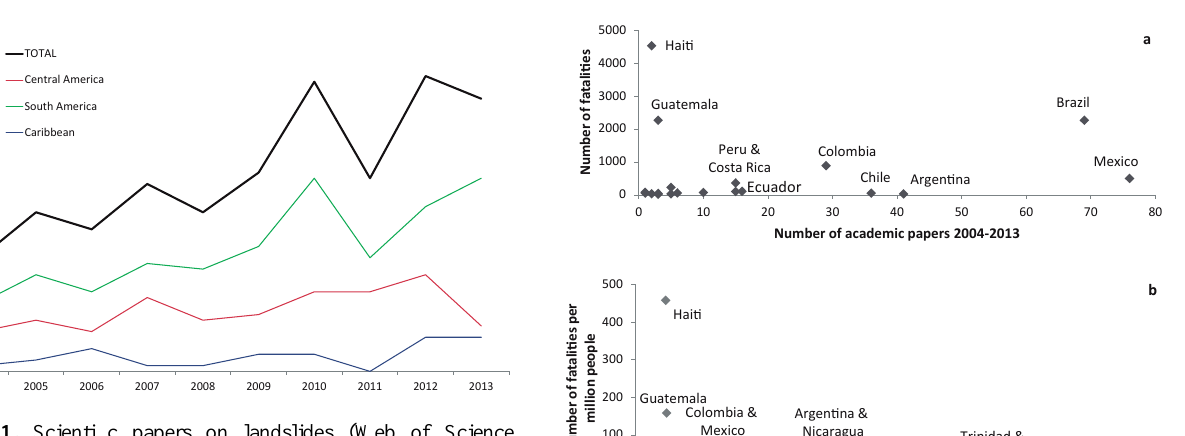
Figure 11. Scientific papers on landslides (Web of Science databases) annual distribution of all countries with recorded fatal landslides.